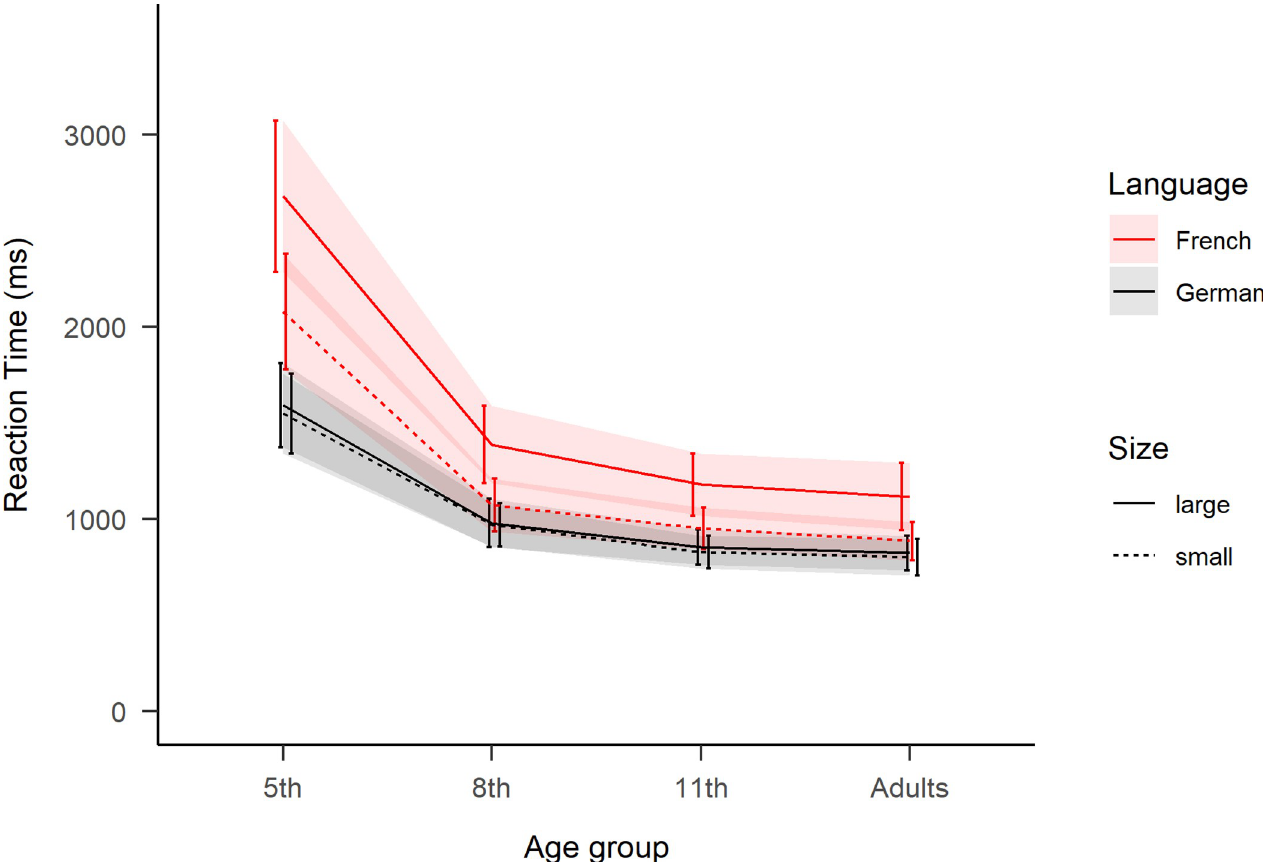
Fig 5. Reaction times in the verbal-visual matching task. For each age group as a function of “Language” and “Number Size”. Large numbers correspond to ‘70s, ‘80s and ‘90s, while small numbers correspond to ‘30s, ‘40s and ‘50s. Ribbons represent standard error.